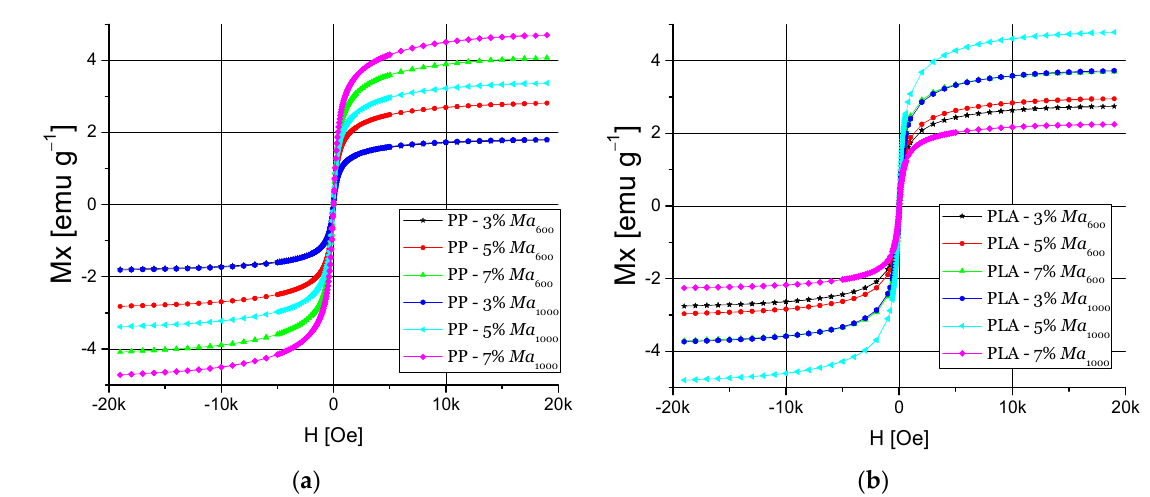
Figure 8. Magnetic hysteresis cycles: ( a ) PP:Ma 600 and Ma 1000 and ( b ) PLA:Ma 600 and Ma 1000 nanocomposites.